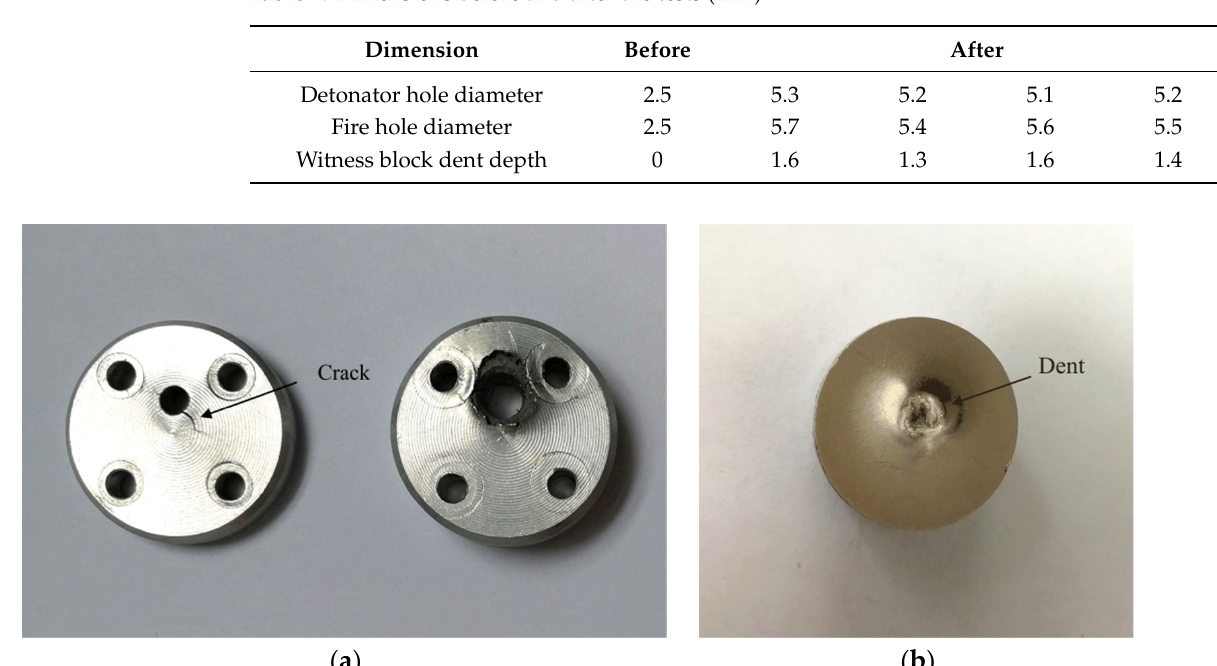
Figure 33. Residual body. ( a ) Upper cover and base; ( b ) Witness block. Table 7. Dimensions before and after the tests (mm).